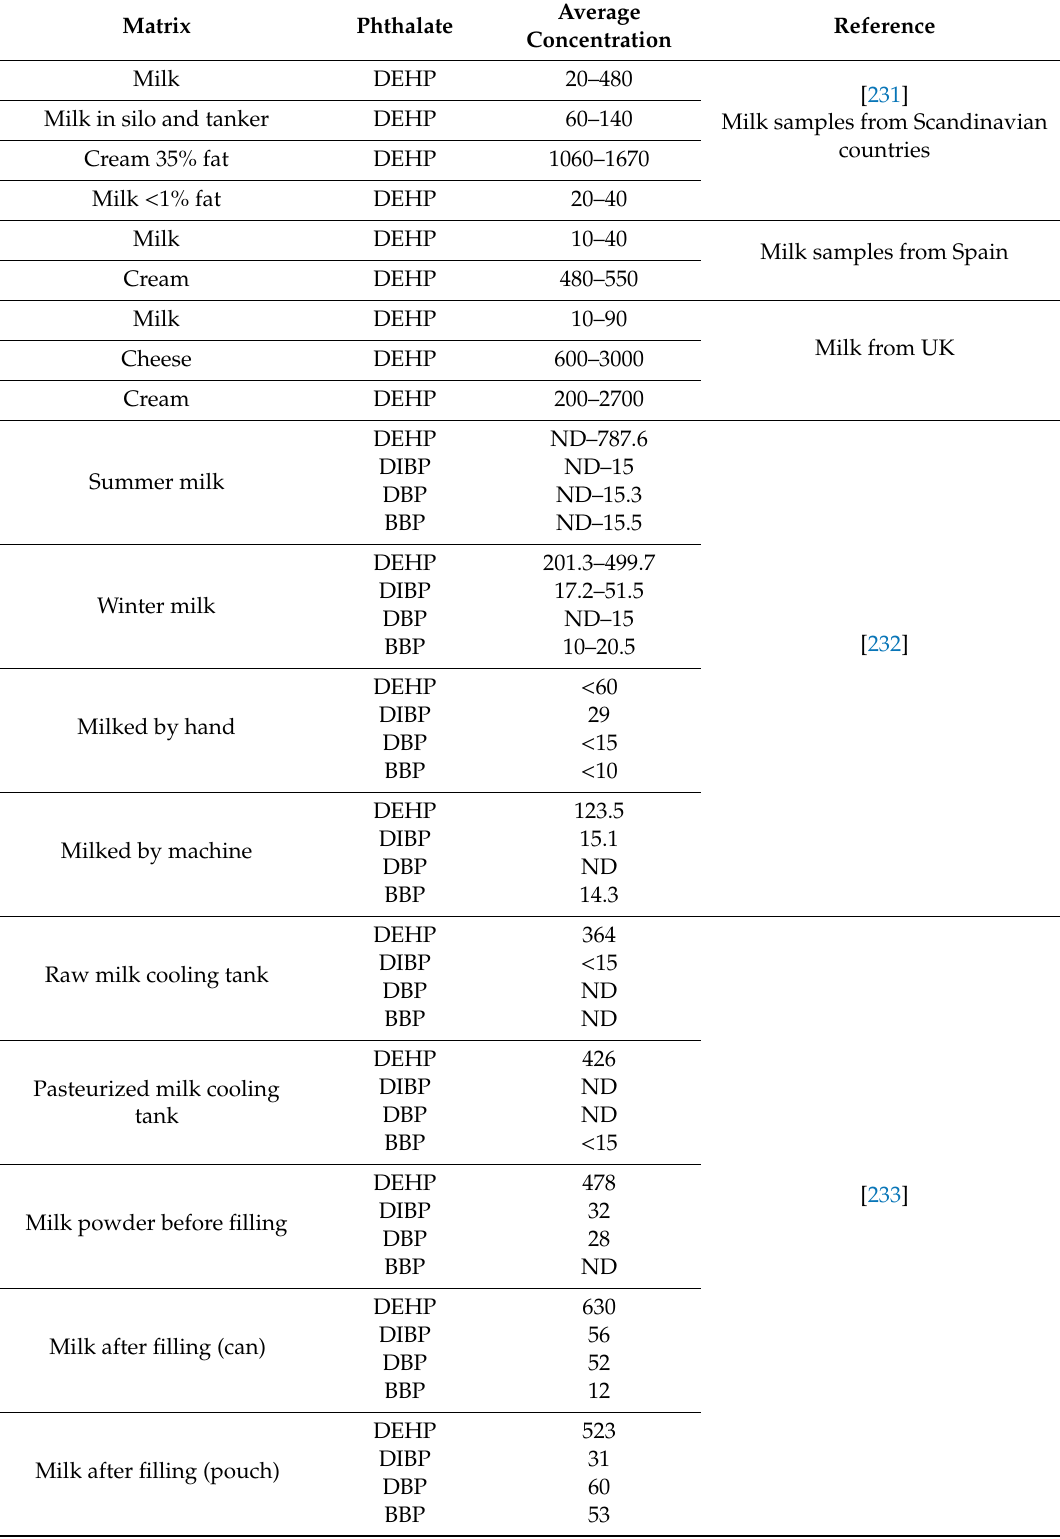
Table 6. Occurrence of phthalates in dairy products ( µ g kg − 1